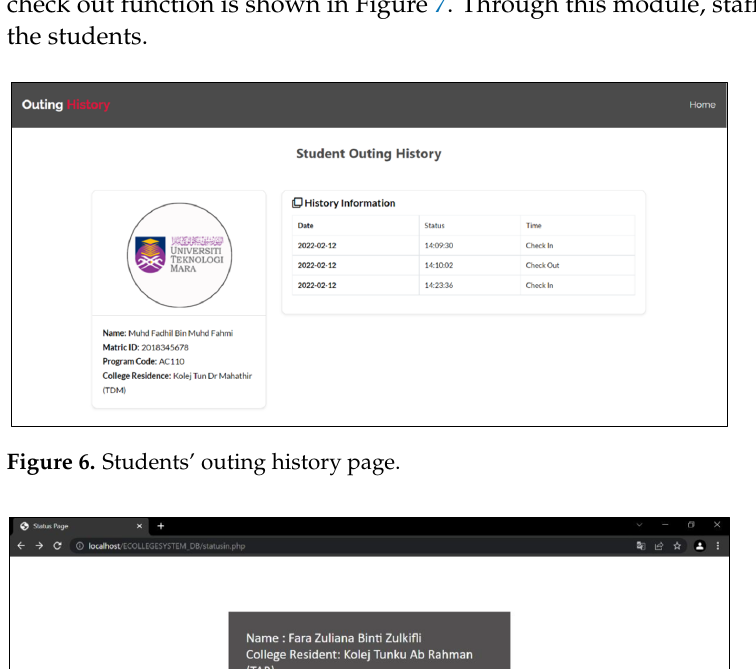
Figure 5. Profile page.